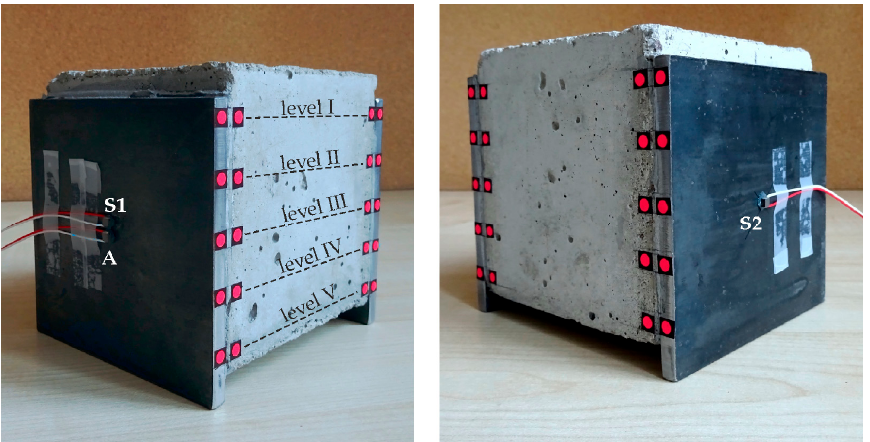
Figure 2. Steel-concrete specimen with attached piezoelectric actuator ( A ) and sensors ( S1 , S2 ).